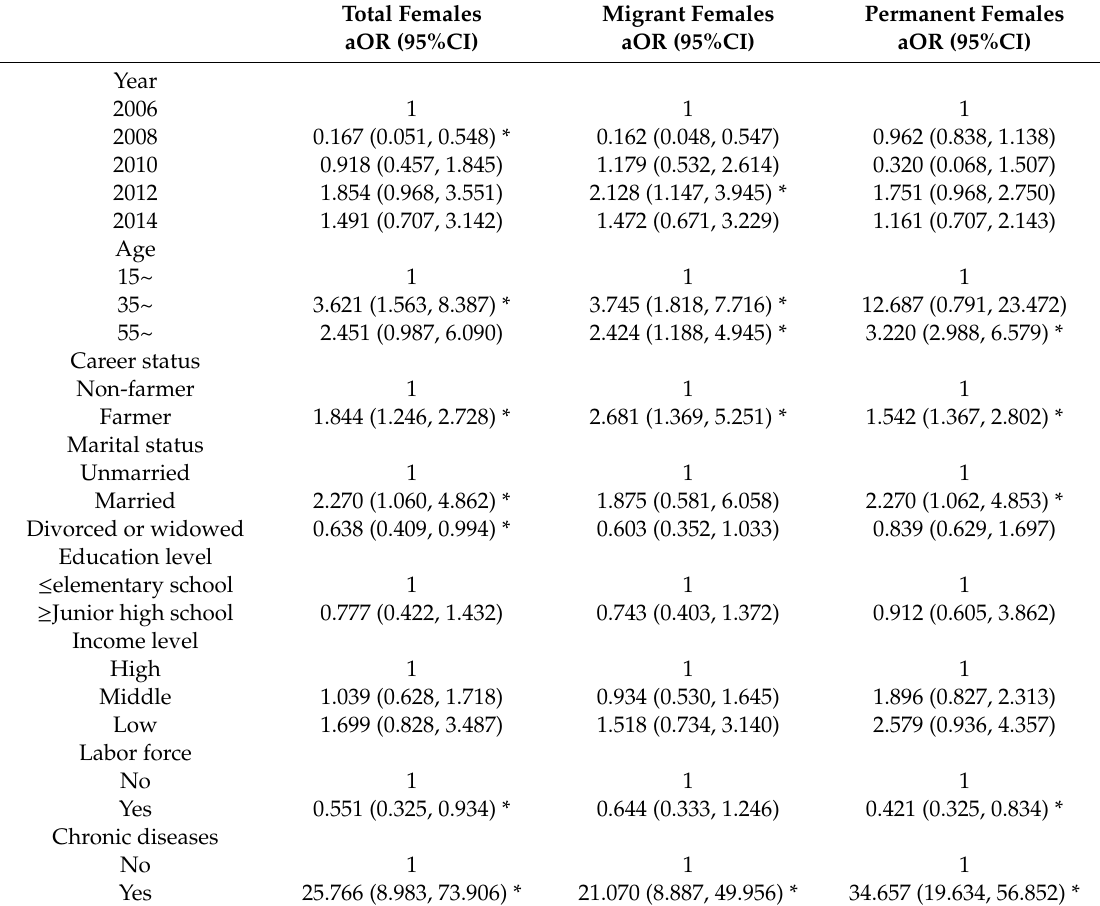
Table 5. The analysis results of hospital avoidance using complex sampling Logistic regression of females aged 15 and over among total females, migrant females, and permanent females.